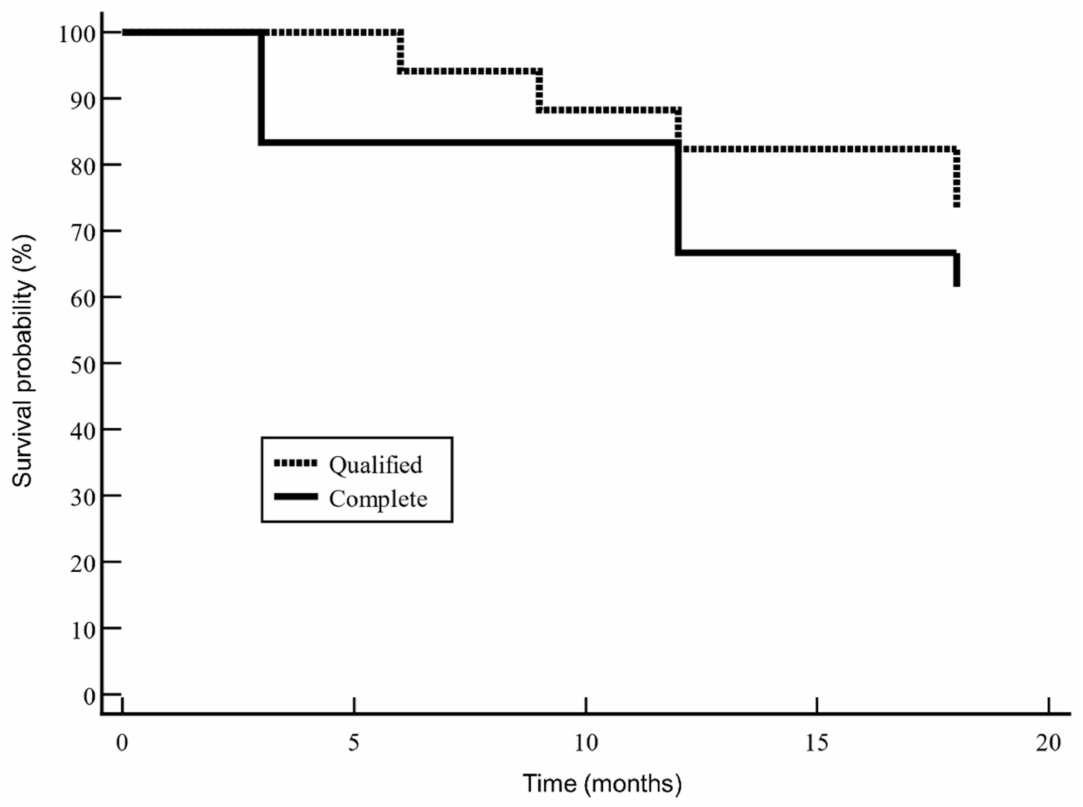
Figure 3. Kaplan–Meier survival curve for complete success. Complete success occurred in 60.9% of eyes, while qualified success occurred in 73.9%.